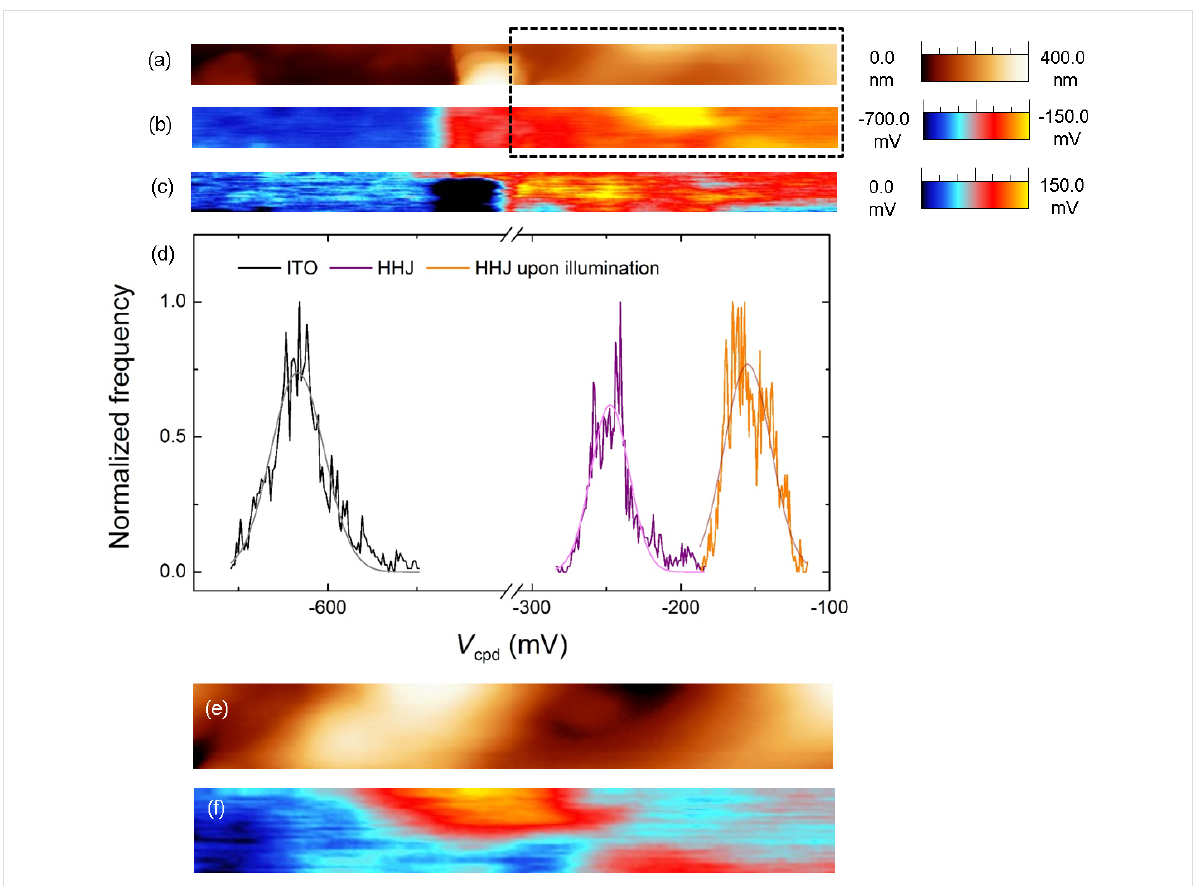
Figure 3: (a) AFM height image obtained in UHV over a 4000 × 270 nm 2 scan area astride the step edge between a TiO 2 /P3HT-COOH HHJ (right- part of the image) and the uncovered part of the ITO electrode (left-part of the image). KPFM height detection parameters: − 5 Hz of frequency shift setpoint and 50 mV of amplitude setpoint. (b) Corresponding KPFM V cpd image recorded without illumination. KPFM V cpd detection parameters: fre- quency and amplitude of the electrical excitation: 958 Hz and 600 mV. (c) Corresponding KPFM V ph image obtained by subtracting the V cpd images recorded with and without illumination. (d) V cpd distributions across a 250 × 500 nm 2 surface area in the left (ITO area) and right (HHJ area) part of image (a) and in the right (HHJ area) part of image (c). Gaussian fits have been added for each distribution. (e) and (f) are enlargements of images (a) and (b), respectively, corresponding to the dashed rectangle. The colour scale contrast is enhanced to highlight the main features.